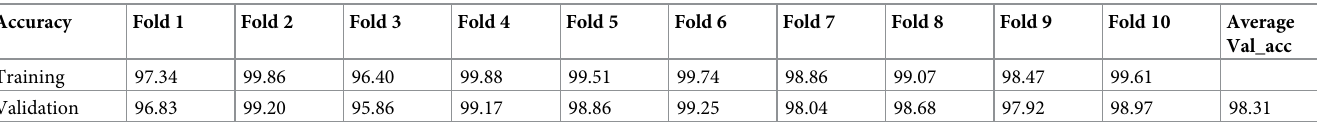
Table 18. Result of 10-Fold cross-validation on augmented dataset.